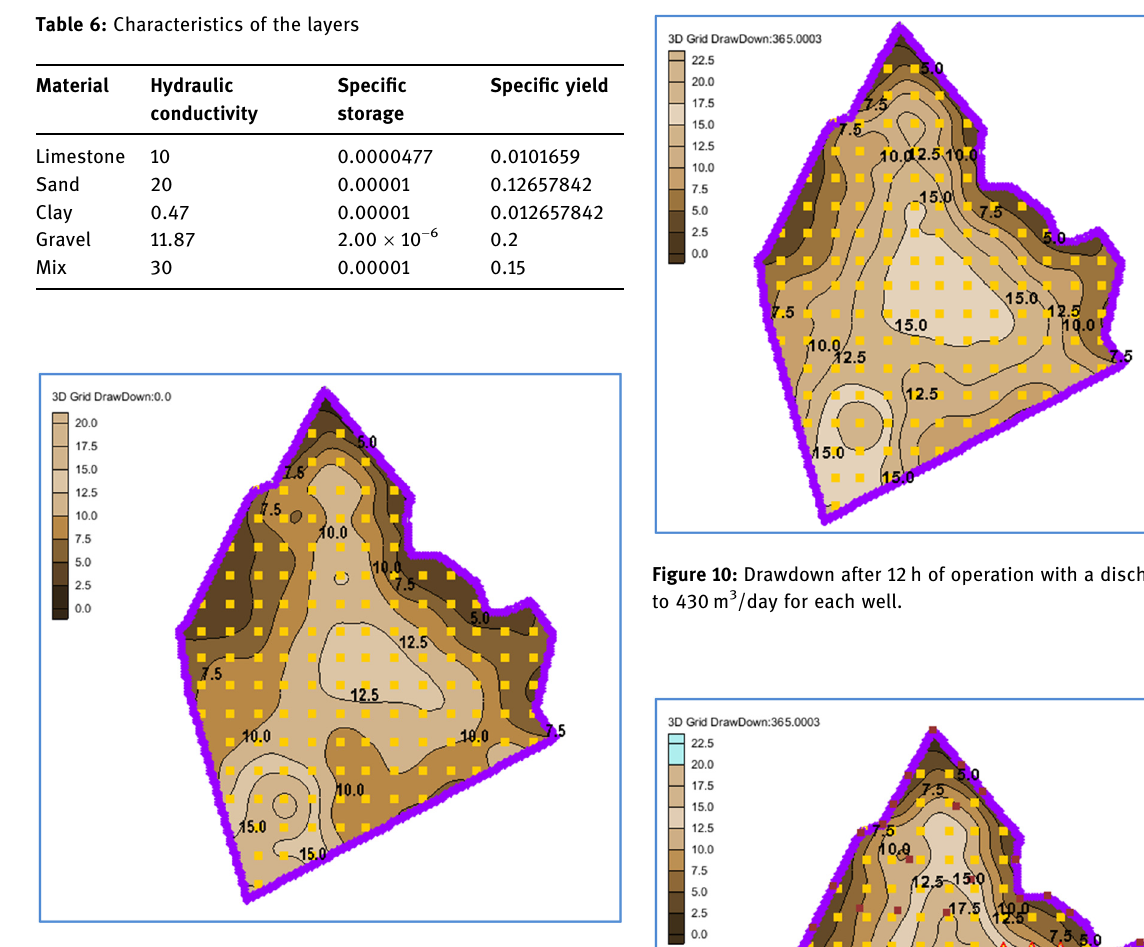
Figure 9: Drawdown after 6 h of operation with a discharge equal to 200 m 3 /day for each well.